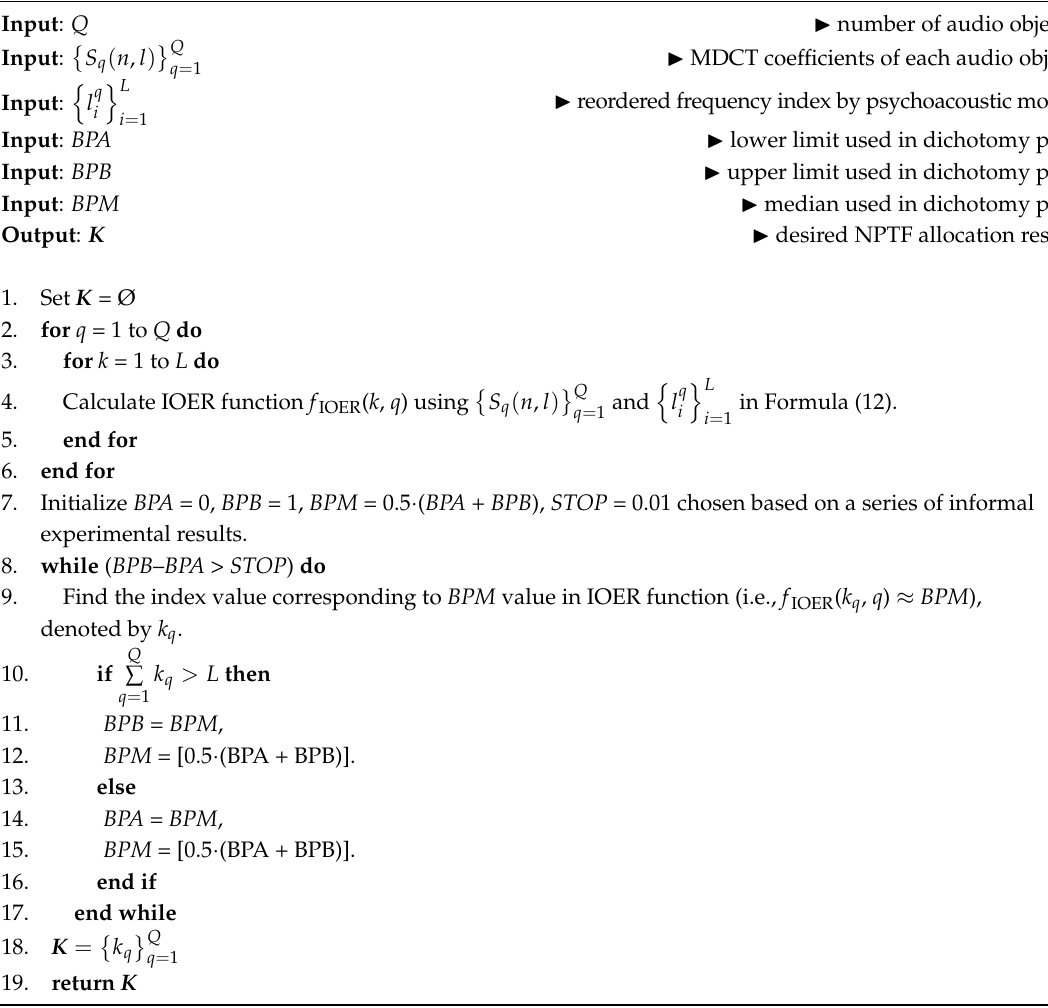
Algorithm 1: NPTF allocation strategy based on bisection